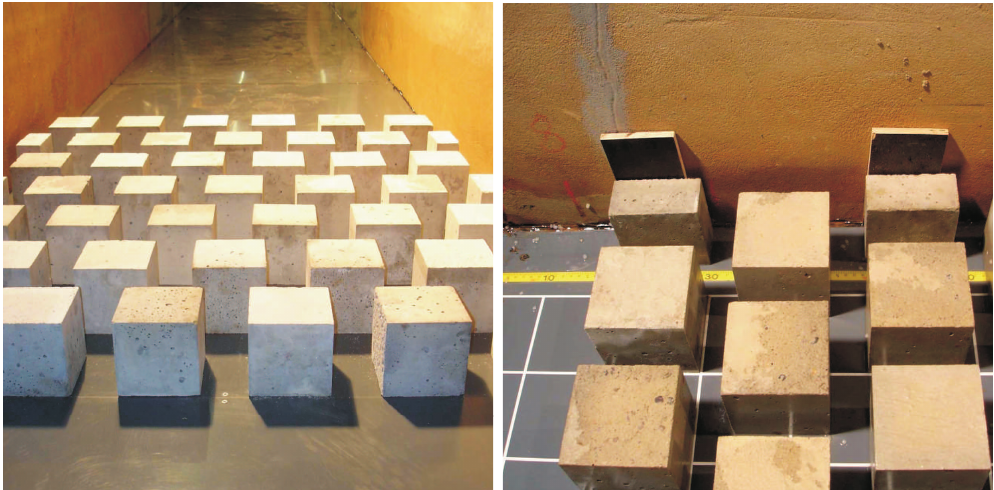
Fig. 5. Photographs of the MR element implementation. Left: Example of a staggered MR element configuration, Right: Half cubes used at the flume walls.